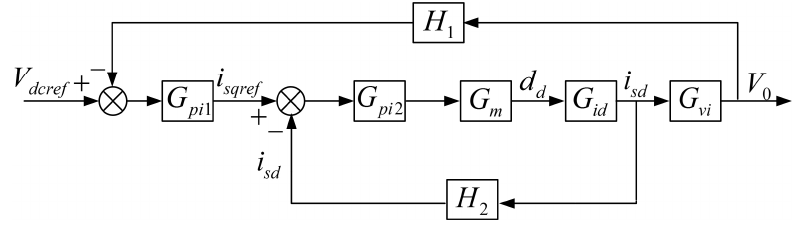
Figure 5. The OSC structure diagram.